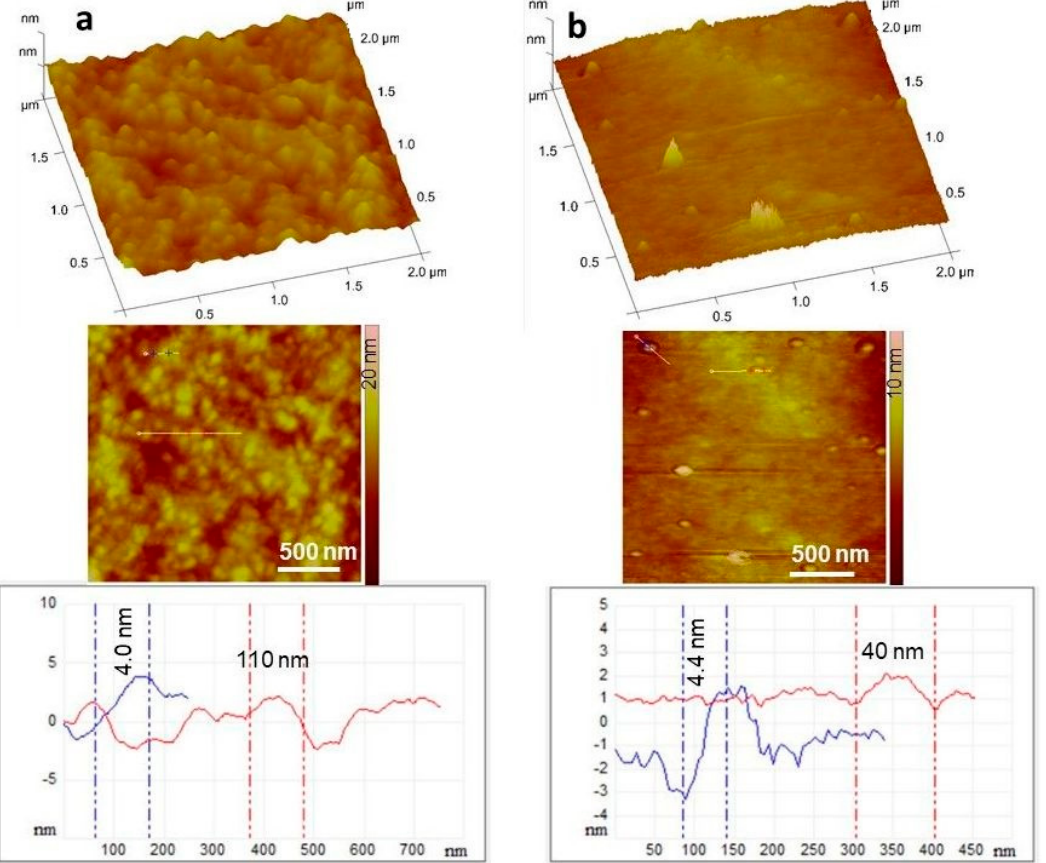
Figure 7. 3D representation, amplitude AFM images of Ref ( a ) and Film 5 ( b ) surfaces with the section analysis curves shown along the indicated white, blue, and red lines. In the composite, the ascorbic acid content was 5% (Film 5).